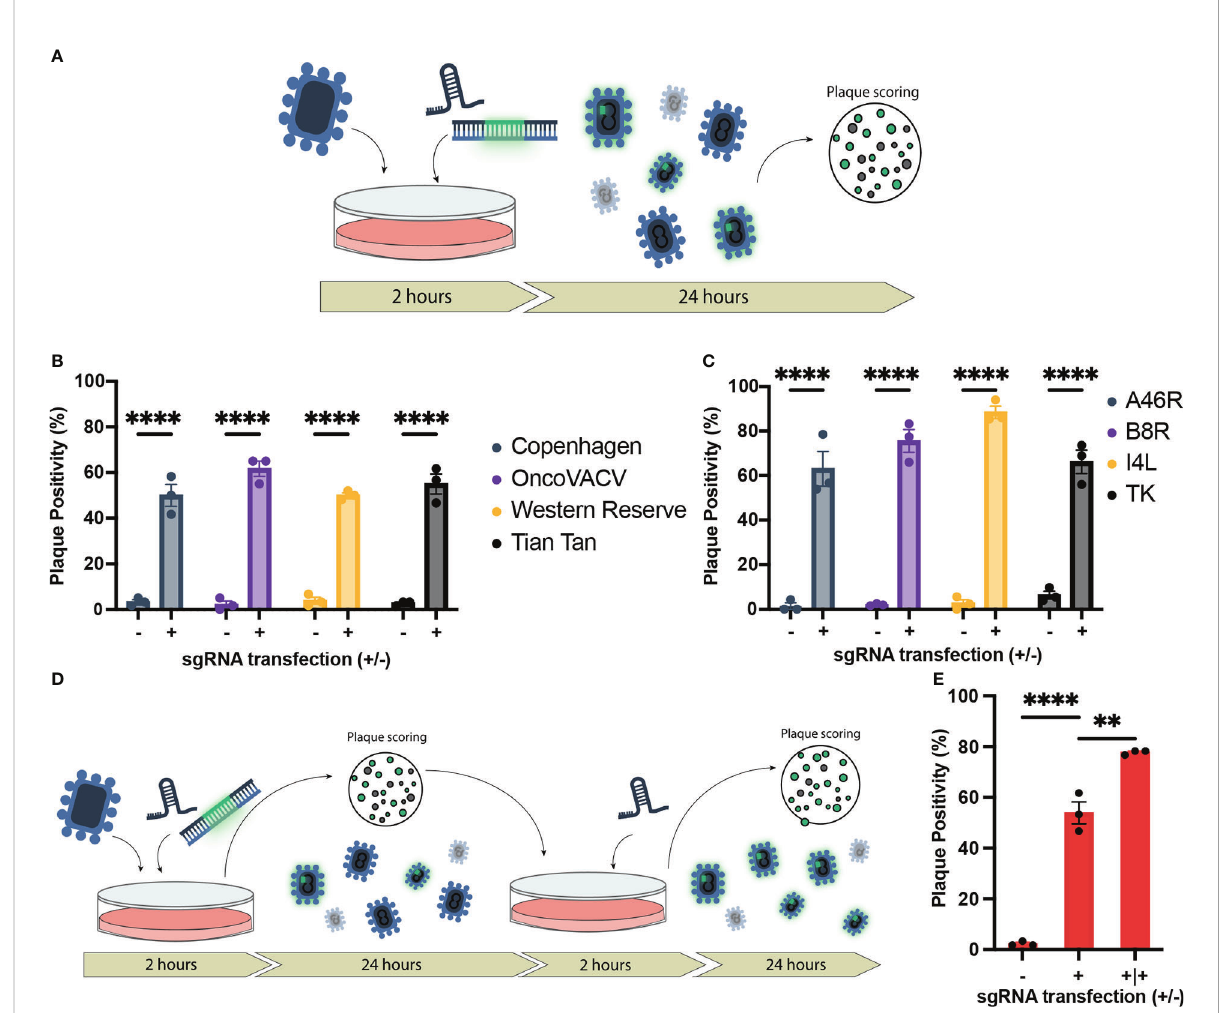
FIGURE 1 Establishment of CRISPR/Cas9-assisted recombinant VACV engineering (CARVE). (A) Schematic of basic recombination protocol. U2OS-Cas9 cells are infected with VACV progenitor strain and subsequently transfected with the homologous recombination template and corresponding synthetic guide RNA for the loci of interest. Bulk virus populations are then collected after 24 hours and used to infect monolayers to score for fl uorescence. (B) Proportion of plaques positive for EGFP inserted at the B8R loci following recombination in various Vaccinia virus strains. U2OS-Cas9 cells were infected with model VACV strains (multiplicity of infection (MOI) = 0.1) and subsequently transfected with the B8R homologous recombination template (HRT) with and without the B8R-targeting single-guide RNA (sgRNA). (C) Proportion of plaques positive for fl uorescent marker following recombination of VACV Copenhagen at various loci (B8R, A46R, J2R, and I4L). Cells were infected at MOI = 0.1 and transfected with the HRT targeting the domain of interest with or without the corresponding guide (n = 3). (D) Outline of CRISPR-Cas9 selection following recombination to enhance recombinant rescue rate. Progeny virus from fi rst step (A) is used to inoculate U2OS-Cas9 cells, which are then transfected with the sgRNA to facilitate selection. (E) Enhancement in proportion of plaques positive for mCherry inserted in the J2R locus following fi rst-round recombination and a single round of selection (n = 3). Data are shown as mean ± SEM (p**<0.1,